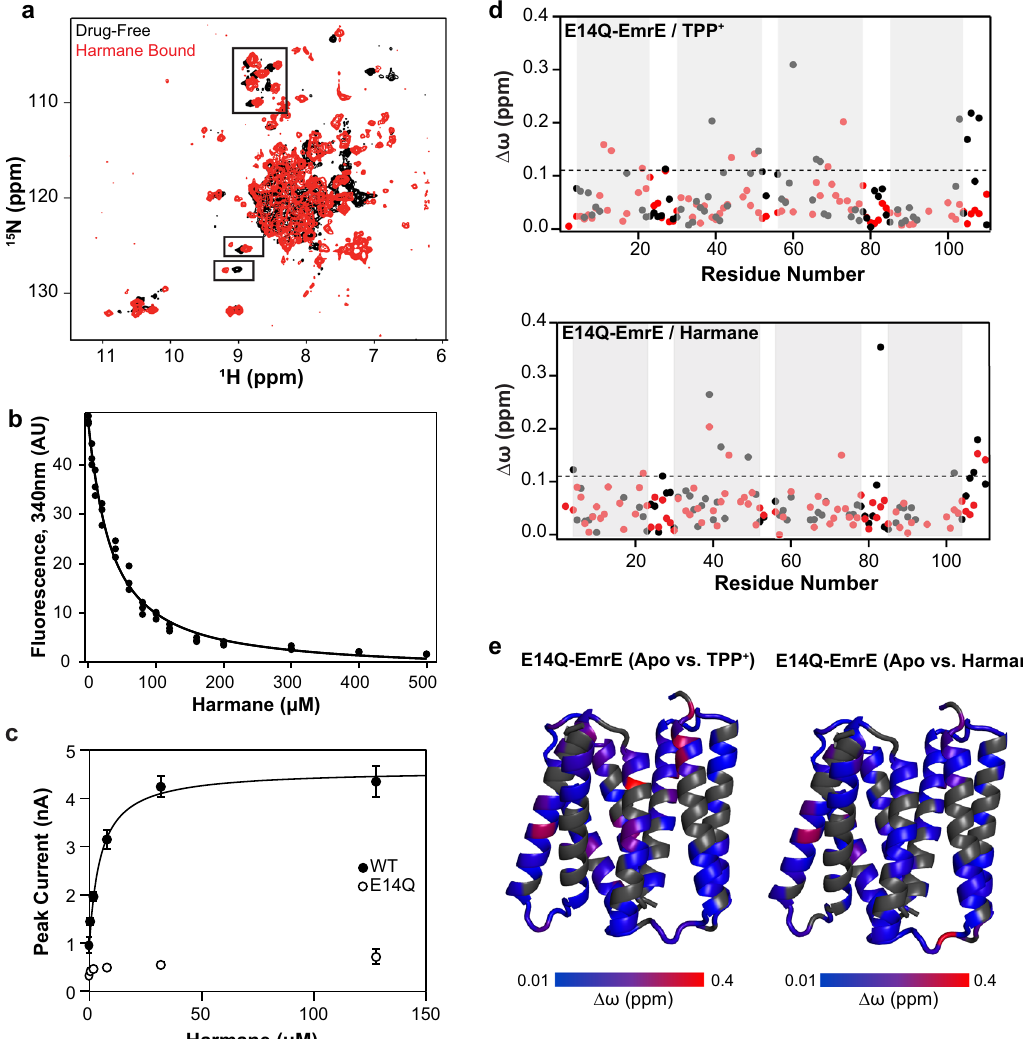
Fig.3|EmrEdirectlybindsharmaneinvitro.a 1 H 15 N-TROSY-HSQCspectraofWT- EmrE in isotropic bicelles ( q =0.33) at 45°C without (black) or with (red) harmane bound. Black boxes highlight some of the localized chemical shift perturbations observed upon harmane binding to EmrE. b Harmane quenches intrinsic trypto- phan fl uorescence of WT-EmrE in a dose-dependent manner, with an apparent K d valueof29±2 μ M.Thisdata( a , b )con fi rmsthatharmanebindsWT-EmrEdirectlyat a speci fi c site. c SSME measurement of EmrE transport current shows that peak current increases with harmane concentration and saturates, consistent with transport gated by harmane binding. The same 2-fold proton gradient (pH 7.0 outsideandpH7.3inside)wasusedasinFig.4.Thetransport fi tsMichaelis – Menten kineticswith a K m value of 5±1 μ M. Thenonfunctionalcontrol(E14Q)displayed no signi fi cant current at any concentration of harmane, con fi rming that harmane-